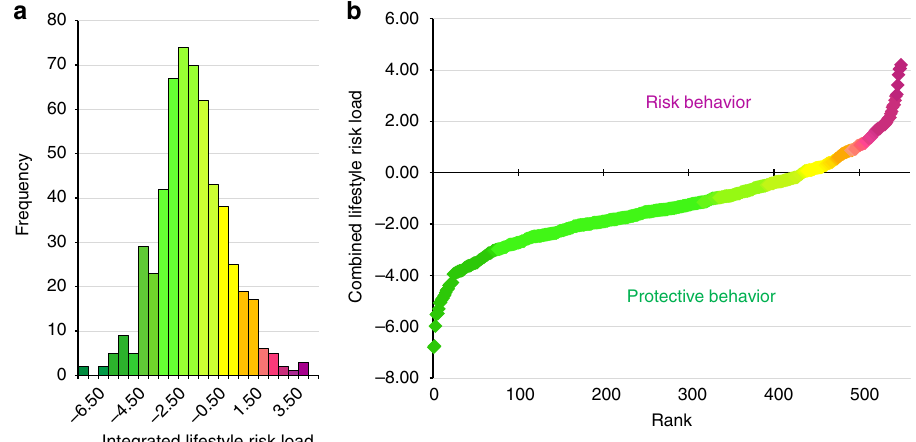
Fig. 1 Combined lifestyle risk measured with the developed combined lifestyle risk score. Lifestyle related data, that is, alcohol consumption (g/week), smoking (pack years), social integration (social integration index 23 ), and physical activity (metabolic equivalent per week 22 ) were z -transformed to obtain uniform measure units. Z -transformed data on the protective variables physical activity and social integration were fi rst multiplied with ( − 1) and then summed up with z -transformed data on the risk variables of alcohol consumption and lifetime smoking. This resulted in an individual score of combined lifestyle risk. a The combined lifestyle risk score shows a nearly normal distribution. b Rank-sorted data of the combined lifestyle risk score: The participant with the lowest score gets rank 1 and the highest rank 549. Green colors indicate more protective lifestyle behavior and magenta colors indicate more